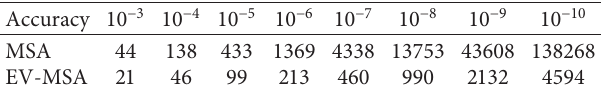
Table 2: Iterations of MSA and EV-MSA at multiple accuracy